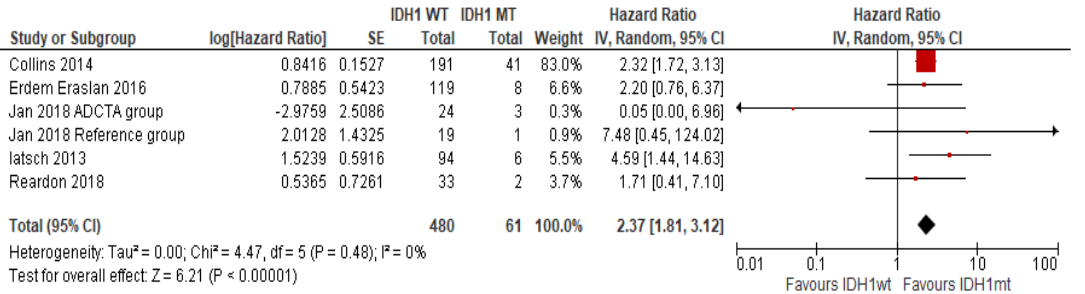
Figure 3. The association of OS with IDH1 mutation status [15,29,30,34,35]. Abbreviations; WT = wild type, MT = mutant, ref= reference. Size of the red square indicates the relative weight of the study as it contributes to the results of the overall comparison. The diamond at the bottom of the forest plot shows the result when all the individual studies are combined and averaged. The effect measure used was HR, where values greater than 1.0 indicate that patients with IDH1 MT has low risk of mortality than patients with IDH1 WT and vice versa for values less than 1.0.